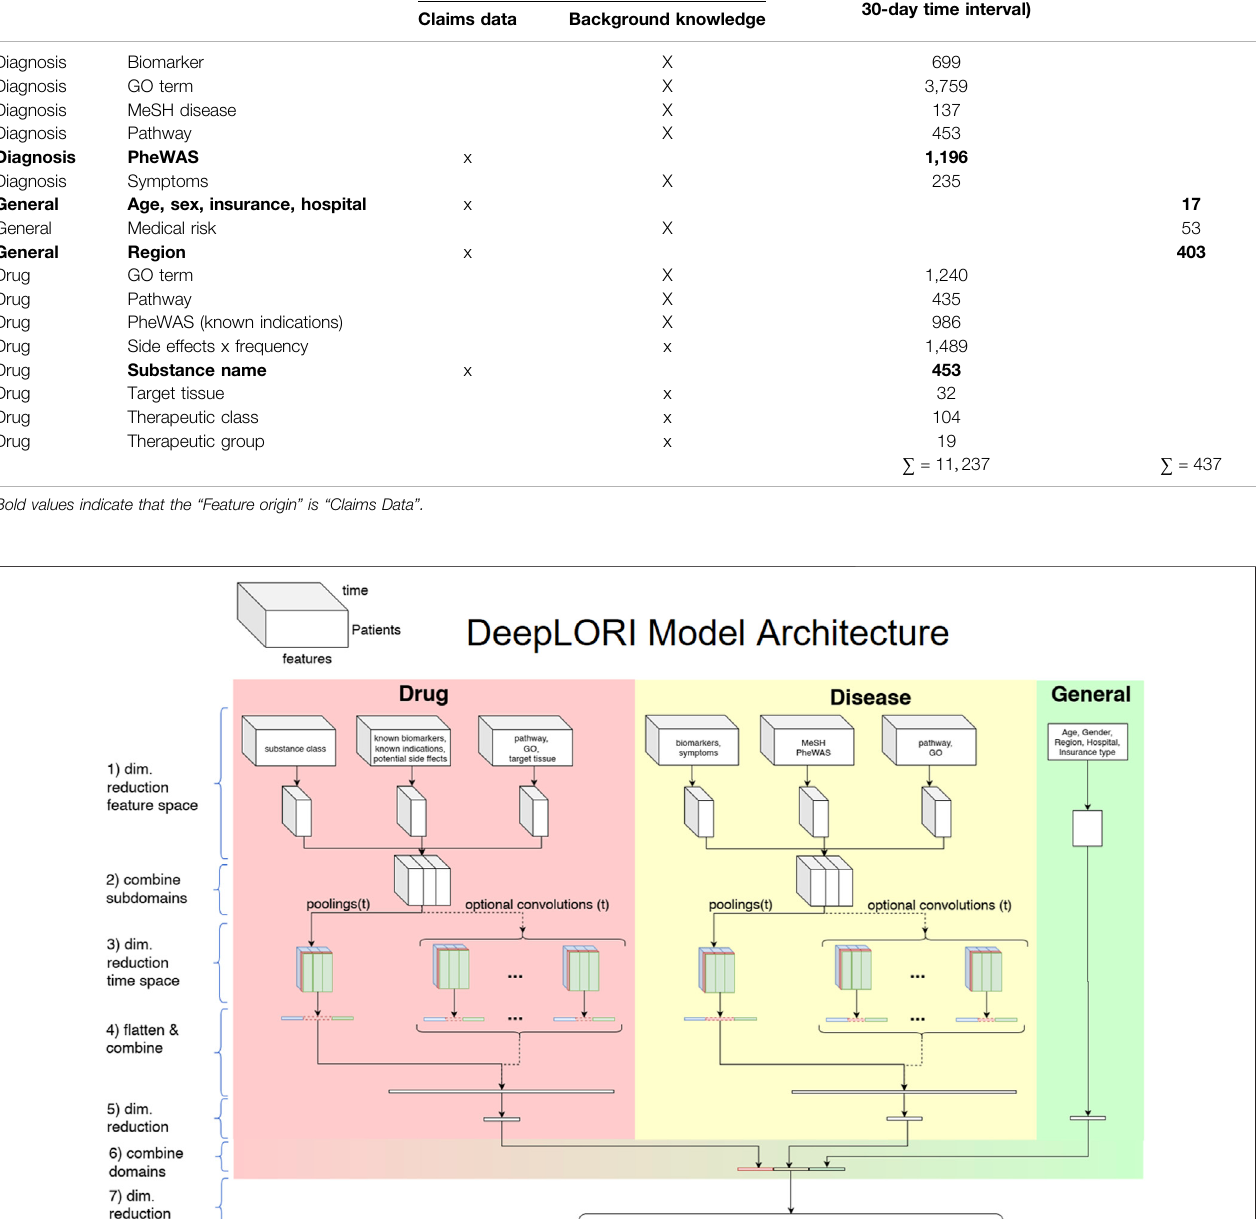
TABLE 2 | Number of features by domain, subdomain, and feature origin (claims data or biomedical background knowledge). Domain